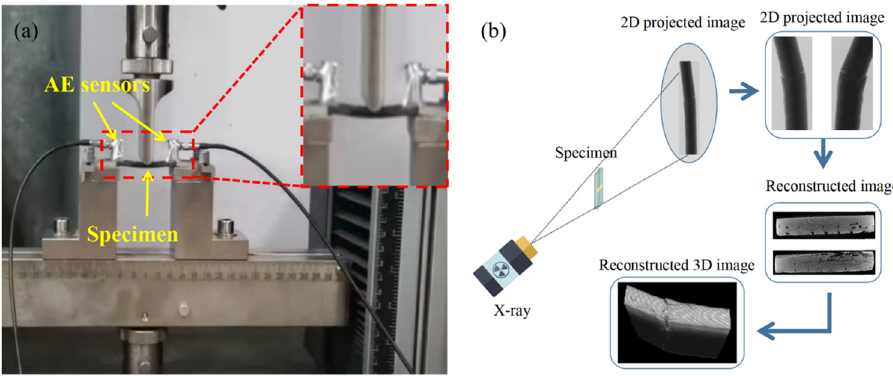
Figure 4: Experimental equipment for bending tests of the composites: ( a ) mechanical and AE experimental system; ( b ) working principle of Micro - CT.